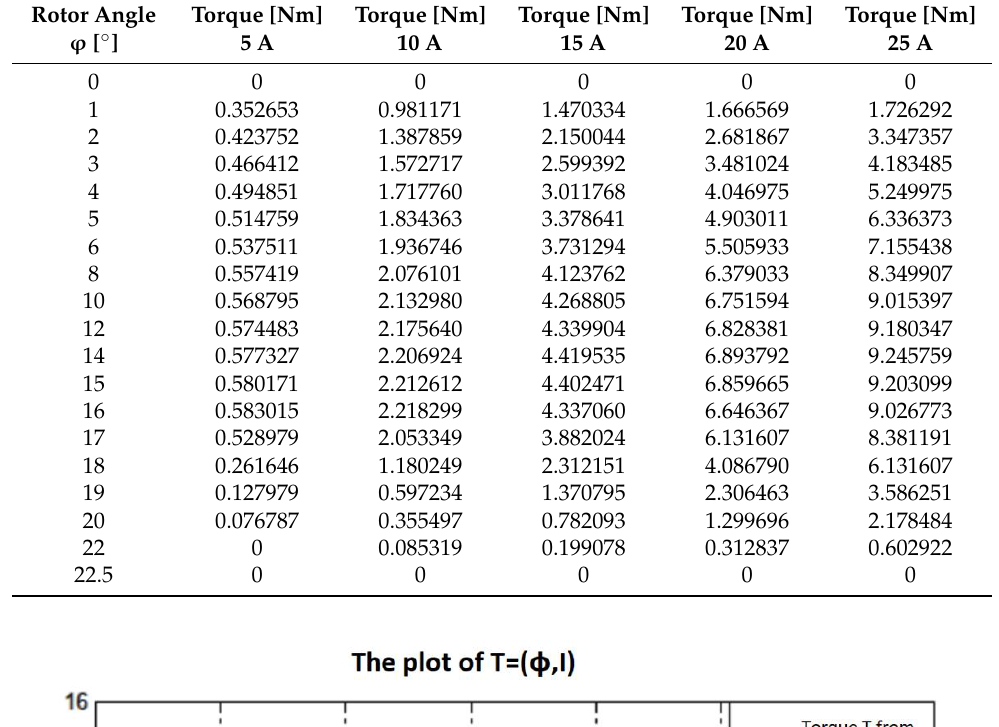
Table 9. A 10/8 motor: torque values for individual angles’ and currents’ values derived from laboratory measurements.